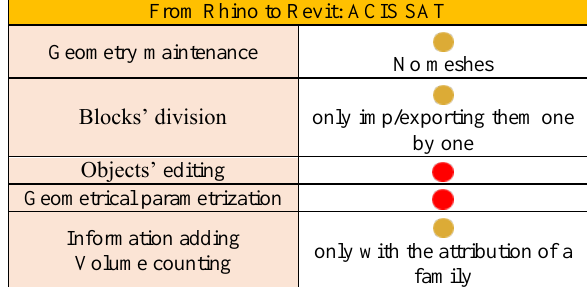
Table 5. Summarizing the result of the SAT